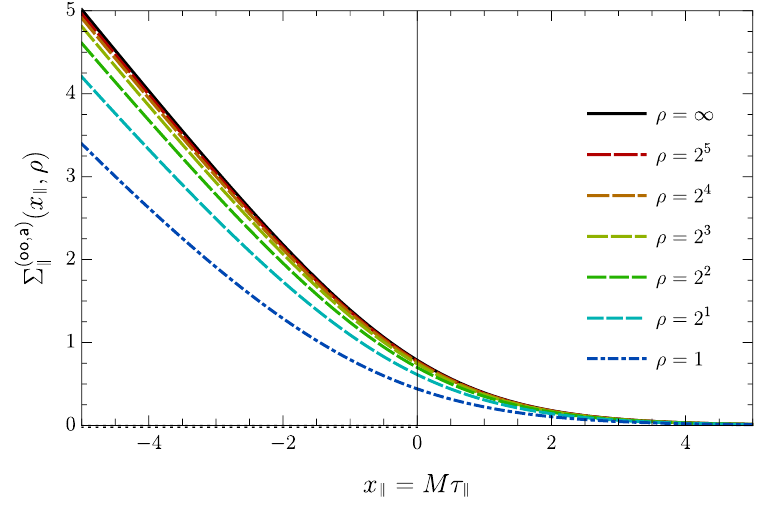
( oo , a ) ( x , ρ ) of the surface tension for different values Figure 6: Scaling function Σ of the aspect ratio ρ ≥ 1. For ρ → ∞ , it converges rather fast to its limiting case ( x ) with the characteristic linear divergence in the ordered phase x < Σ ( a ) b